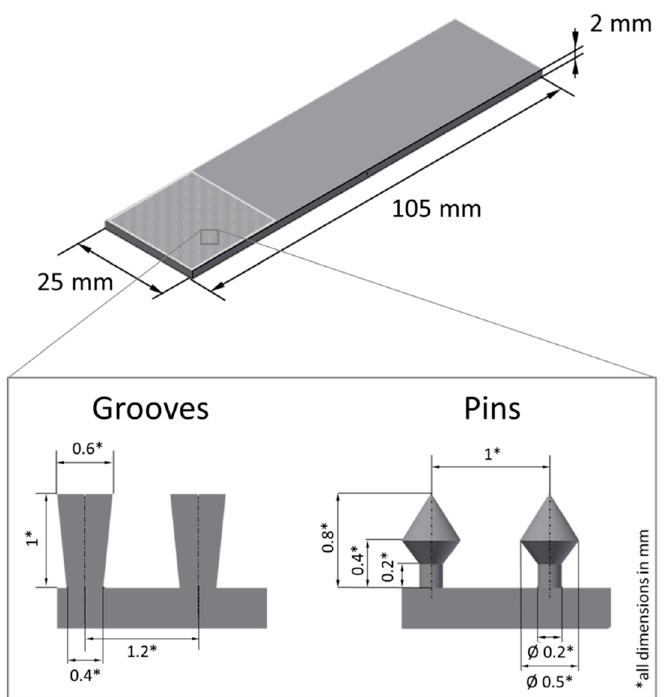
Figure 2. Geometry of tensile test specimens. The enlarged section shows the design and dimensions of the groove- and pin-shaped surface structures.